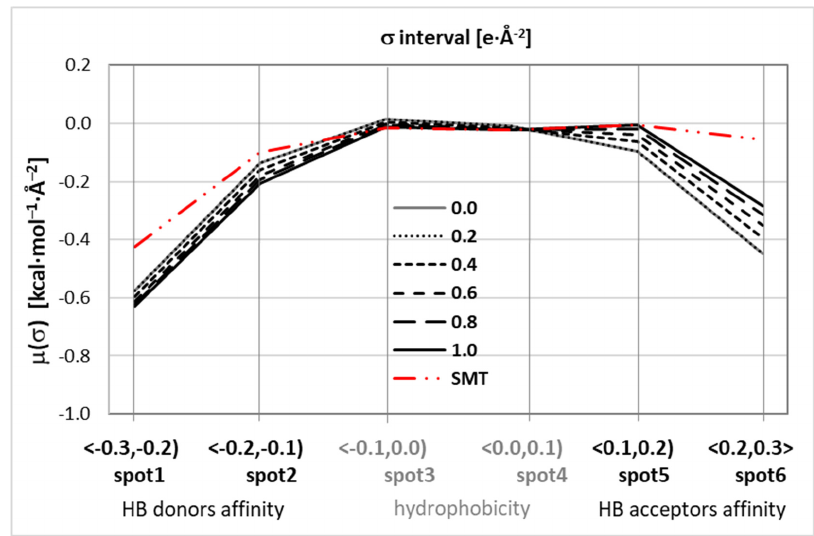
Figure 5. Distributions of the values of descriptors characterizing SMT in aqueous methanol binary mixtures at room temperature. Series correspond to systems differing in mole fraction of organic solvent.